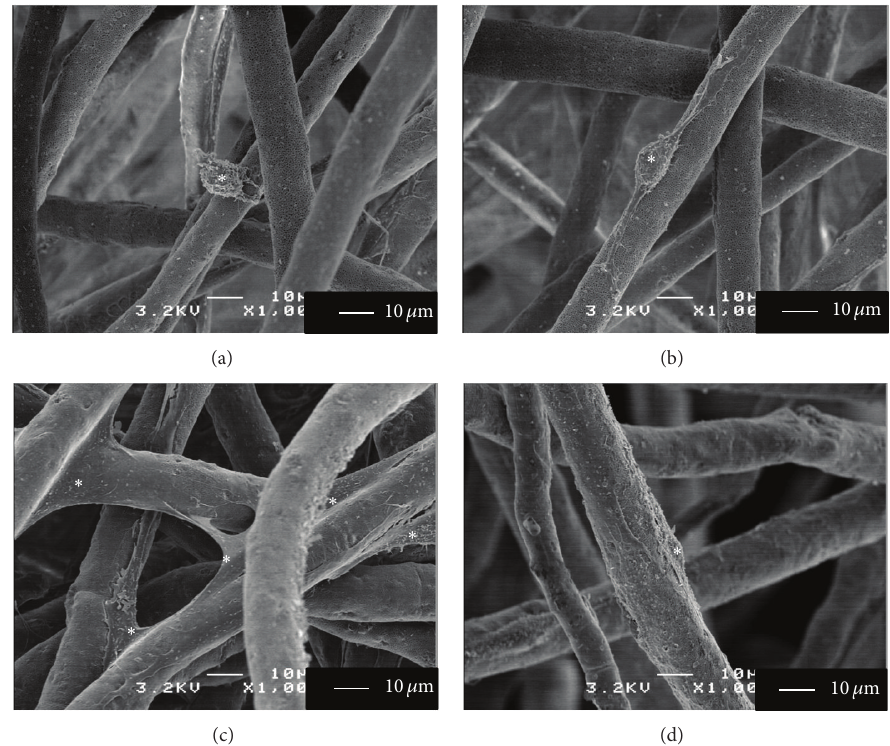
Figure 4: SEM images of MC3T3-E1 cells after 3h of incubation on ((a), (b)) PLLA/SiV and ((c), (d)) PLLA/SiV-INT(10-5). Asterisk indicates the attached